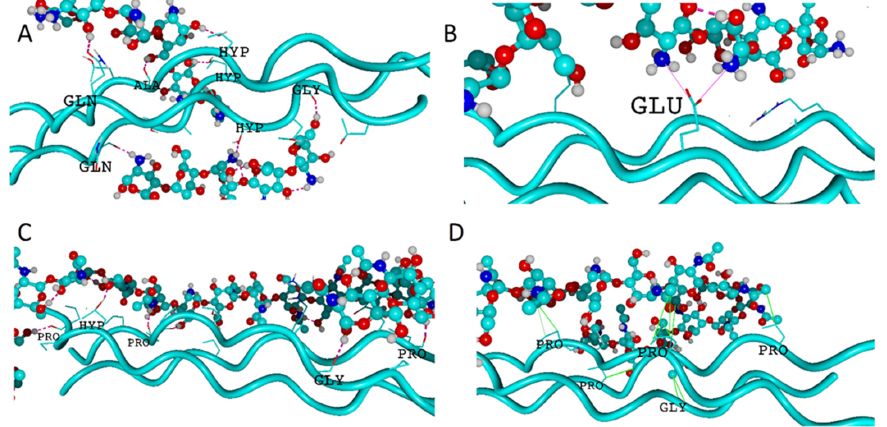
Figure 3. Visualization of collagen type II helices interacting with chitosan. The panels ( A – D ) represent exemplary snapshoots of the complexes characterized by HD = 1/DD = 1, HD = 0.5/DD = 1, HD = 0.5/DD = 0.5, and HD = 0/DD = 0.125, respectively. Hydrogen bonds were denoted by pink dotted lines, while ionic contacts by solid pink lines. Solid green lines stand for hydrophobic contacts. Collagen helices are presented as solid turquoise lines, whereas chitosan is represented by ball-stick model with colors representing: carbon-turquoise, nitrogen-dark blue, oxygen-red, and hydrogen-white.